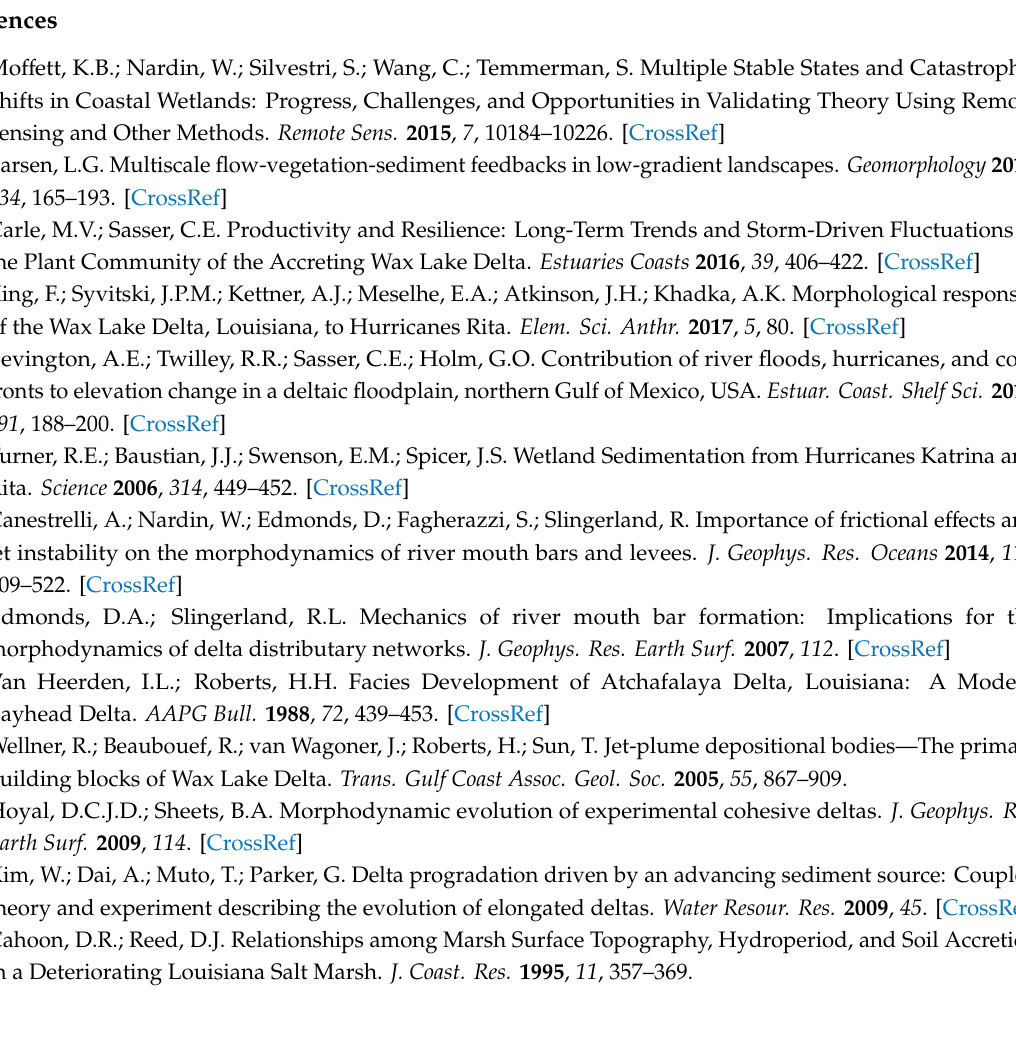
WLD elevations from WLD geometric factors, Table S1: Dates of Landsat imagery, Table S2: Dates of tropical storms and hurricanes, Figure S1: HIME raster exposure probability models for Pintail Island, Figure S2: Surface water data and water level models, Figure S3: WLD HIME elevation maps, Figure S4: Elevation maps predicted by each timeframe’s multiple linear regression model, Figure S5: Mapped residuals of elevations predicted by each timeframe’s multiple linear regression model minus the HIME-predicted elevation map for that timeframe, Figure S6: Histograms of magnitude of HIME elevation change between successive timeframes, Figure S7: Elevation probability distributions through time within each 1 km-band of distance from the delta apex, Figure S8: Progression of approximate WLD topset slope through